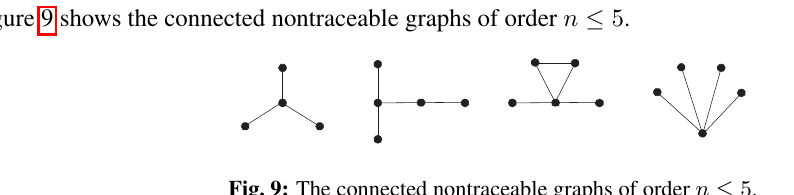
Fig. 9: The connected nontraceable graphs of order n ≤ 5